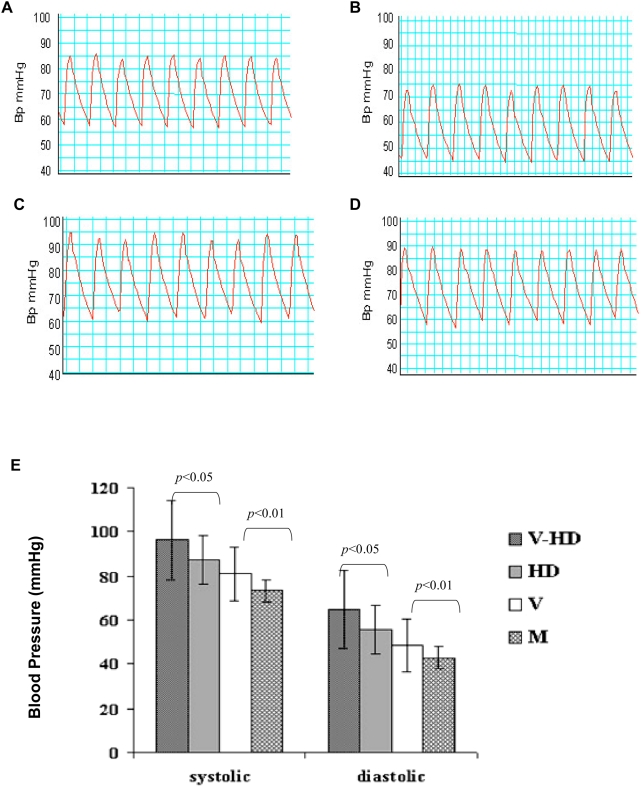
Tracing blood pressures by carotid artery catheter.A representative blood pressure tracing in a mouse from each assay group is shown (12 mice were in each group). (A) Mouse infected by MCMV. (B) Mock-infected. (C) Mouse infected by MCMV and fed a high cholesterol diet. (D) Mouse mock infected and fed a high cholesterol diet. (E) The mean value of ABp from each assay group (mmHg). V-HD: mice infected by MCMV and fed with a high cholesterol diet. HD: mice mock-infected and fed with a high cholesterol diet. V: mice infected by MCMV and fed with a regular diet. M: mice mock-infected and fed with a regular diet. Blood pressures in each group were measured at week 10 of experiment. The mean values of systolic and diastolic pressure were determined and calculated with Chart v4.1.2 software, respectively. Statistical significance between assay groups was determined with Student's t test. The base line blood pressure of a mouse from each assay group before MCMV infection is shown in Table S1.